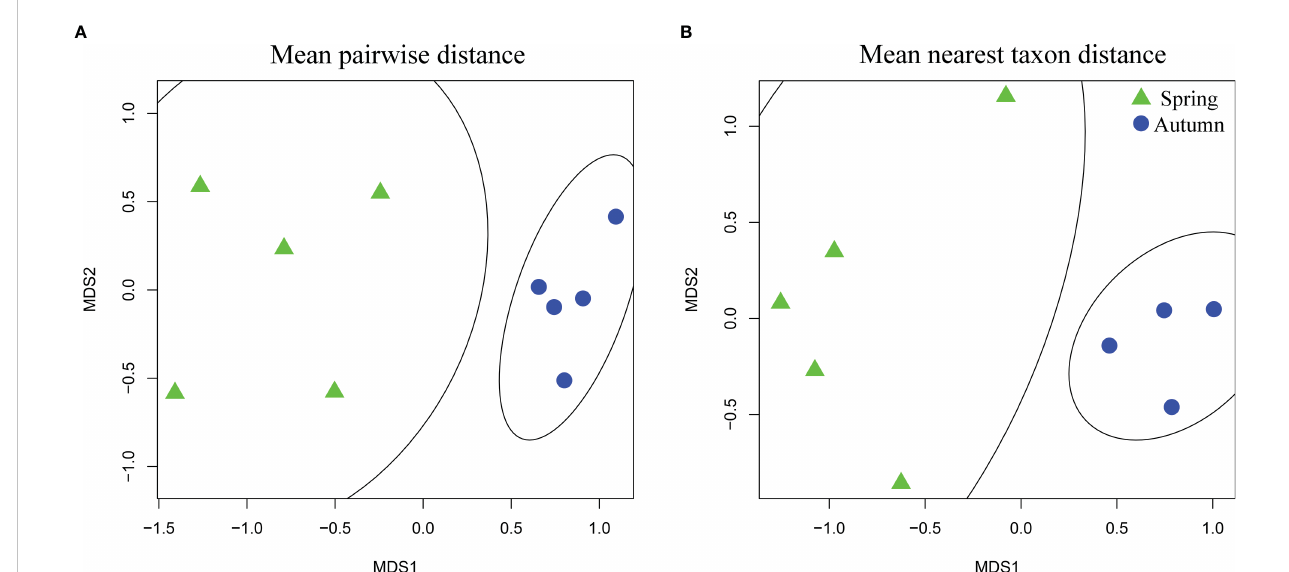
FIGURE 5 Nonmetric multidimensional scaling ordination plots of phylogenetic alpha diversity of nektonic communities occurring in spring and autumn based on mean pairwise distance (A) and mean nearest taxon distance (B) .